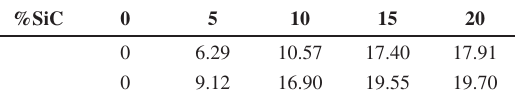
Figure 6. Effect of shaping method on compressive properties of Al-SiC Table 4. Difference between YP and strain of HP and EX samples.